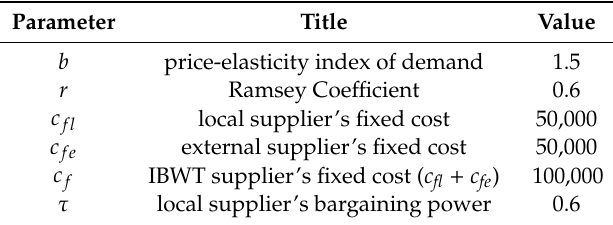
Table 3. Parameters in the IBWT horizontal supply chain for the numerical